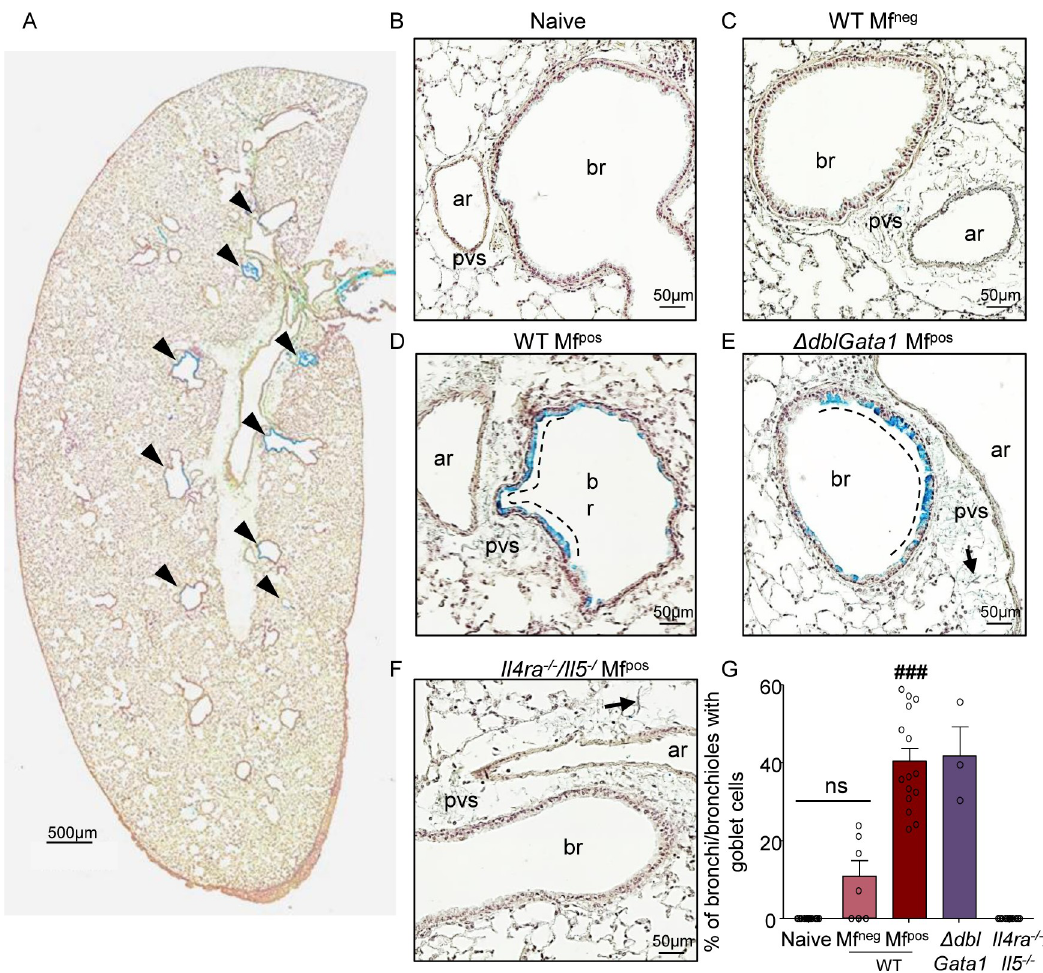
Fig 5. Absence of IL-4R impairs bronchial inflammation in microfilaremic mice. L . sigmodontis infected wild type (WT), Δ dblGata1 and Il-4ra -/- /Il-5 -/- BALB/c mice were euthanized at 70 days p.i. Alcian Blue-PAS staining of left lung sections was performed to analyse the mucus secretion. ( A ) Representative left lung whole section of a WT Mf pos mouse showing mucus- producing bronchial epithelium (arrow head) and a thickened posterior visceral pleura. Bronchial epithelium lacking mucus producing goblet cells in ( B ) na ï ve, ( C ) WT Mf neg and ( F ) Mf pos Il-4ra -/- /Il-5 -/- mice. Presence of mucus-producing goblets cells in bronchial epithelium of ( D ) WT Mf pos and ( E ) Δ dblGata1 Mf pos mice with preferential localization of goblet cells close to perivascular space (pvs). Arrows show Mfs in pvs; br = bronchus; ar = artery ( G ) Percentage of bronchi containing mucus- producing goblet cells; results are expressed as mean ± SEM (pool of 1–3 experiments). n = 10 naive, n = 7 WT Mf neg , n = 15 Mf pos , n = 3 Δ dblGata1 Mf pos , n = 12 Il-4ra -/- /Il-5 -/- . For each mouse, 2–3 lung sections were analyzed. Kruskal-Wallis followed by a Dunns multiple comparison test: ### p < 0.001 represent difference between naive and